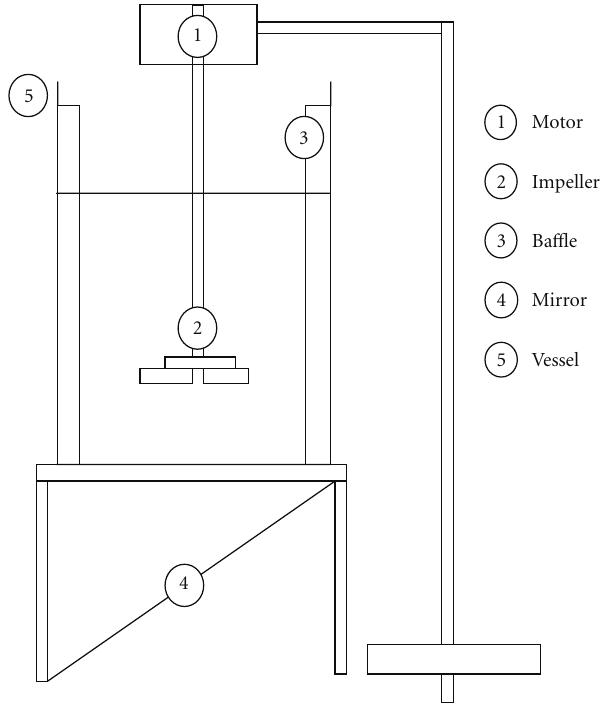
Figure 1: Schematic of experimental setup of motor, agitator, tank, and